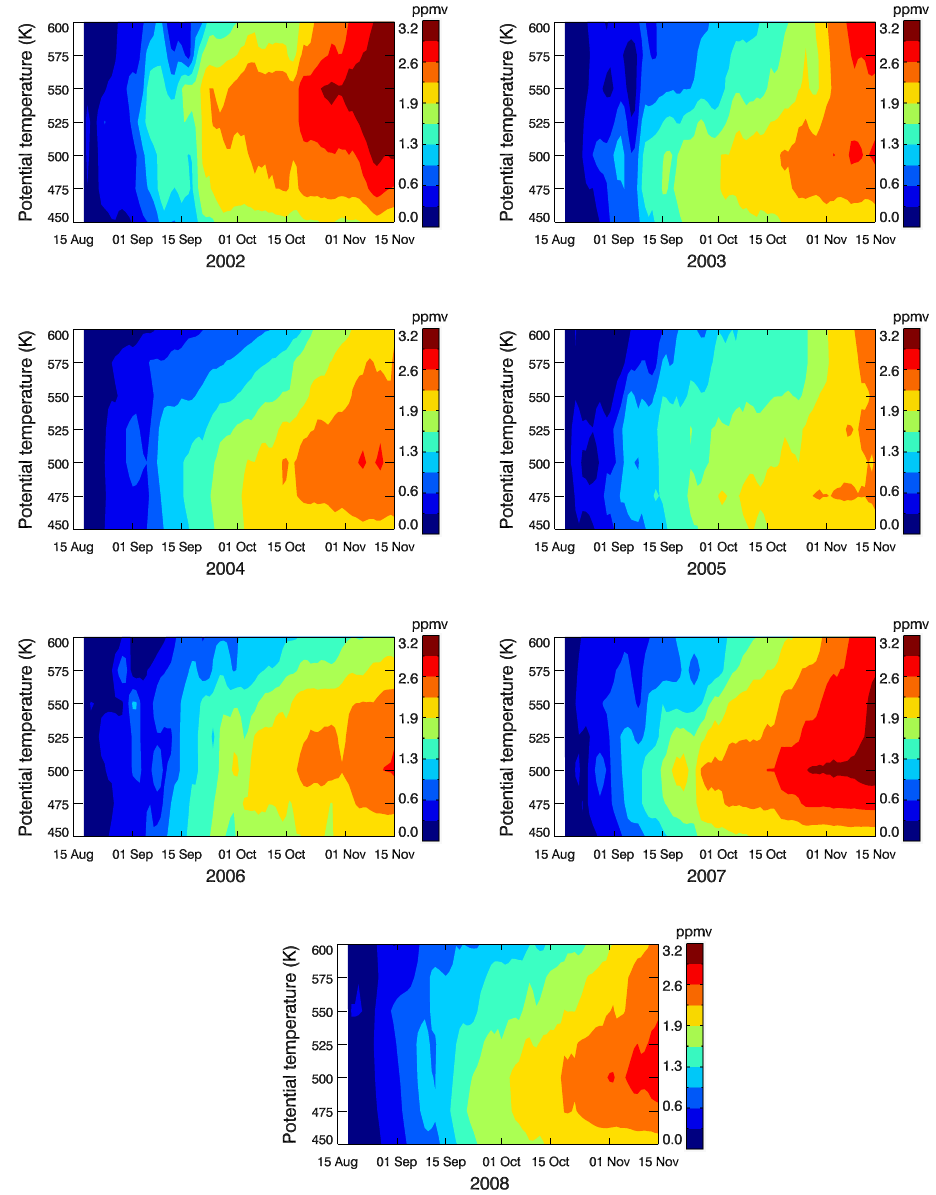
Fig. 11. Derived vortex average ozone losses as a function of time and potential temperature between the 450K and 600K isentropic levels in the Antarctic winter stratosphere for the years 2002 to 2008. The period August 15 – 22 was used as the reference period for the derivation of the chemical ozone losses and the ozone losses are determined starting on August 18 of each year.